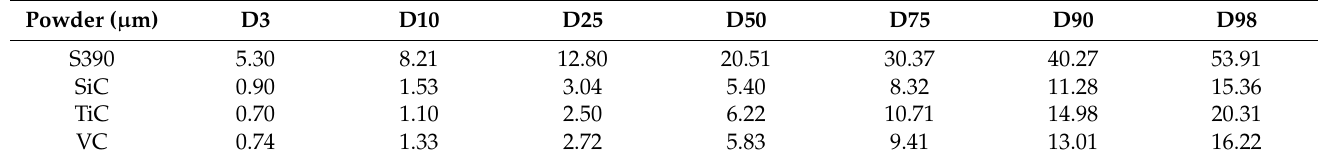
Table 3. The size distribution of the raw S390 and MC-type carbide